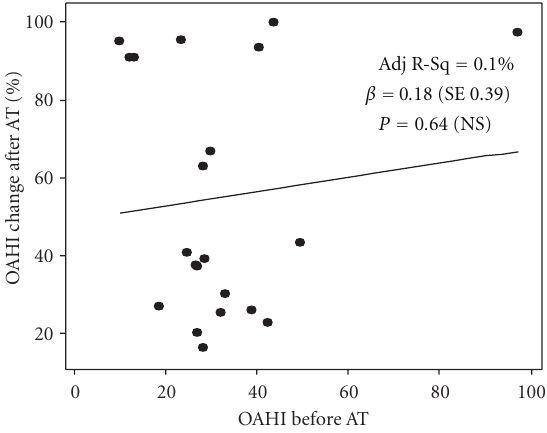
Figure 2: Univariate linear regression model (OSA severity). Graph demonstrates the correlation between obstructive apnea-hypopnea index (OAHI) before AT and the percentage of OAHI change after adenotonsillectomy (AT) in obese adolescents. Adj R-Sq: adjusted coe ffi cient of determination. β : parameter estimate. ± standard error